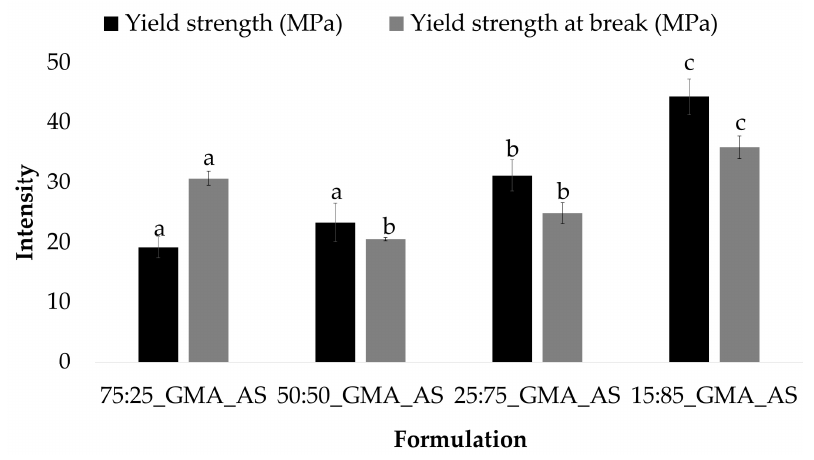
Figure 3. Yield strength (MPa) and yield strength at break (MPa) ( n = 5) for PCL/PLA formulations at different concentrations. Mean ± SD. Different superscripts within the same parameter indicate statistically significant different values ( p < 0.05).